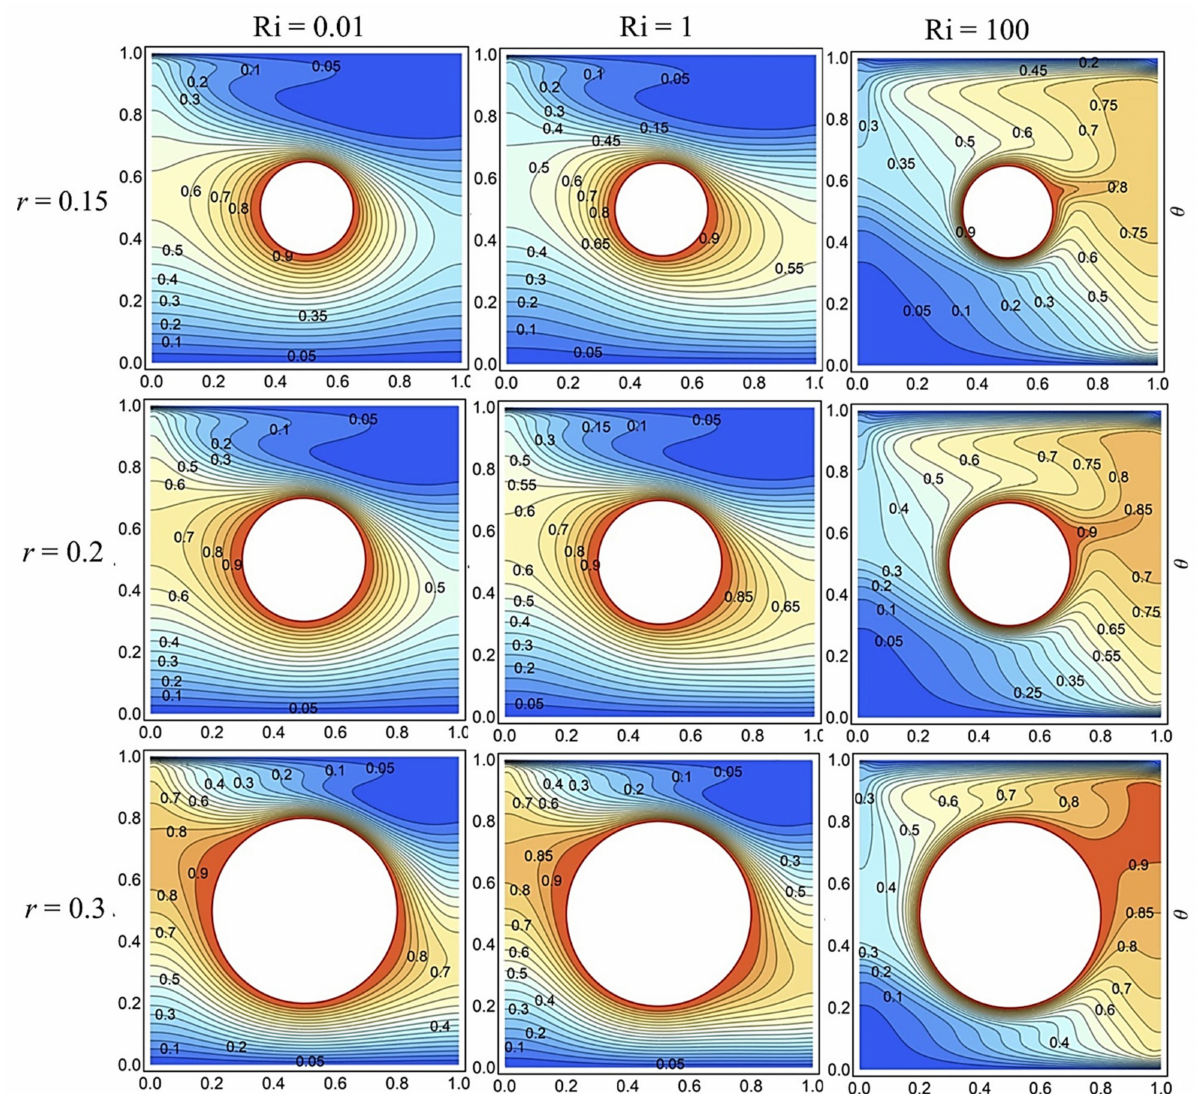
Figure 4. Isotherms for different Richardson number and radii of center heater while the other parameters φ hnf = 0.02, Ha = 50, Re = 100, α = 45 ◦ , and β = 0 ◦ are kept fixed.